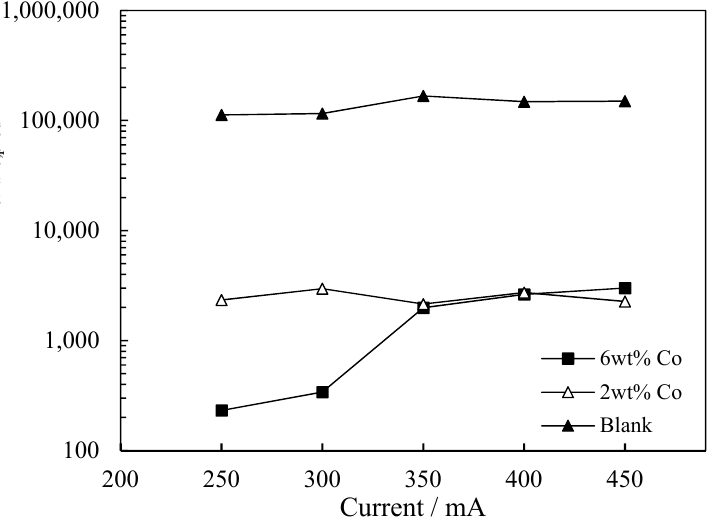
Figure 10. Specific required energy (MJ/molmethane, prod) as a function of current for plasma- catalytic FTS (NTP + Blank, 2 or 6 wt% Co catalyst) at a discharge time of 60 s. Legend: (cid:4) —6 wt% Co; ∆ —2 wt% Co; (cid:78) —Blank. Operating conditions: Syngas (H 2 /CO) ratio: 2.2:1; pressure: 2 MPa; inter-electrode gap: 1 mm; wall temperature: 25 ◦